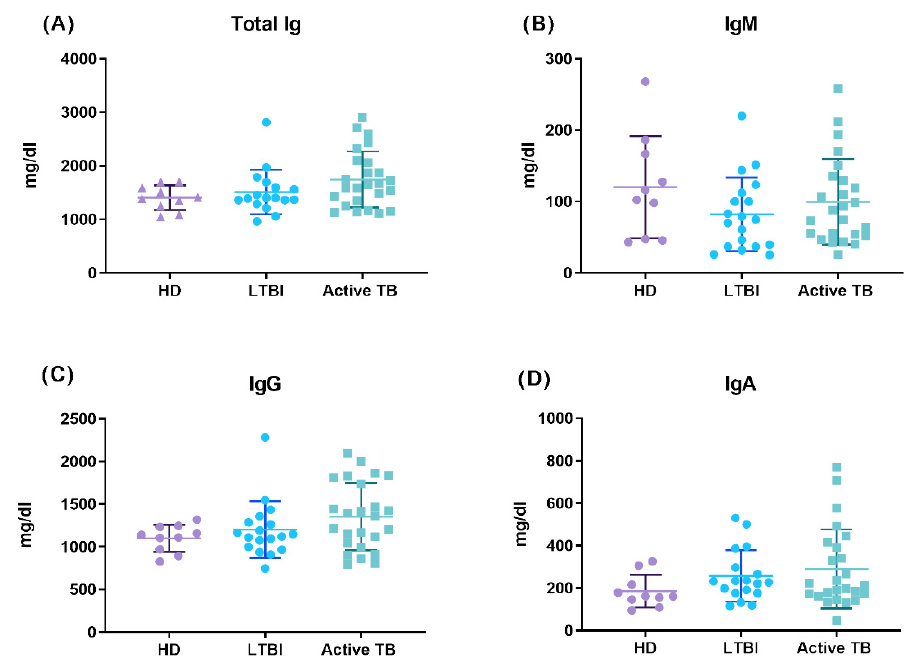
Figure 5. Quantitative analysis of total serum Ig ( A ), IgM ( B ), IgG ( C ), and IgA ( D ) immunoglobulins, from whole blood serum, among the groups; each dot represents one individual subject out of 20 LTBI, 25 Active TB, and 10 HD. The dot plots represent the mean and SE of each group.